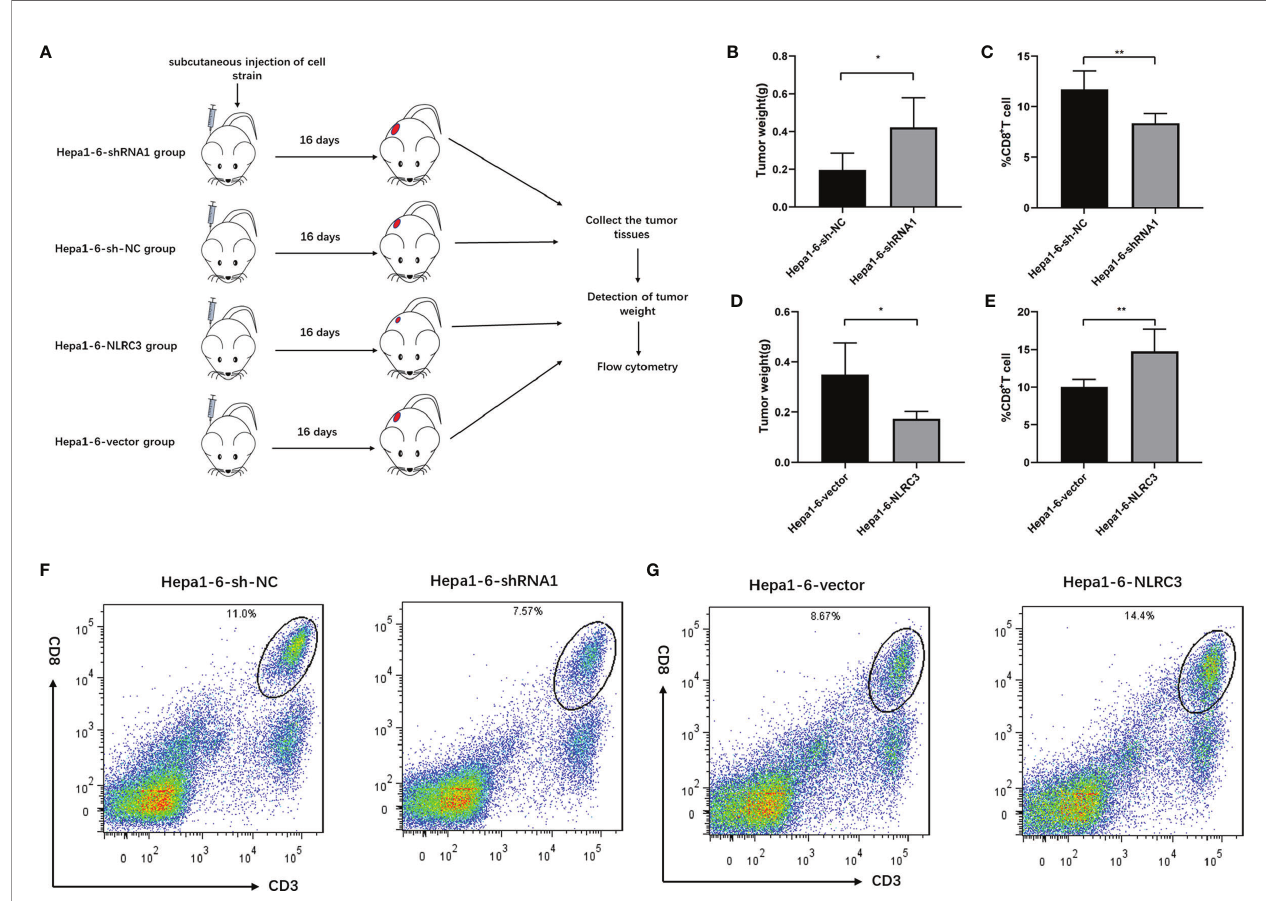
FIGURE 4 | NLRC3 promotes CD8 + T cell in fi ltration in tumor-bearing mouse models. (A) Tumor bearing mouse models were divided into 4 groups. (B) Compared to Hepa1-6-sh-NC group, the tumor weights were signi fi cantly increased in the shRNA1 group (* P =0.0220). (C) Compared to Hepa1-6-sh-NC group, the percentages of CD3 + CD8 + T cells were signi fi cantly decreased in the shRNA1 group (n=5) (** P =0.0053). (D) Compared to Hepa1-6-vector group, the tumor weights were signi fi cantly decreased in the Hepa1-6-NLRC3 group (* P =0.0178). (E) Compared to Hepa1-6-vector group, the percentages of CD3 + CD8 + T cells were signi fi cantly increased in the Hepa1-6-NLRC3 group (n=5) (** P =.0094). (F) Representative Flow cytometry analysis of CD8 + T cells on day 16 showing percentages of CD3 + CD8 + T cells in the Hepa1-6-sh-NC and Hepa1-6-shRNA1 groups. (G) Representative Flow cytometry analysis of CD8 + T cells on day 16 showing percentages of CD3+CD8+ T cells in Hepa1-6-vector and Hepa1-6-NLRC3